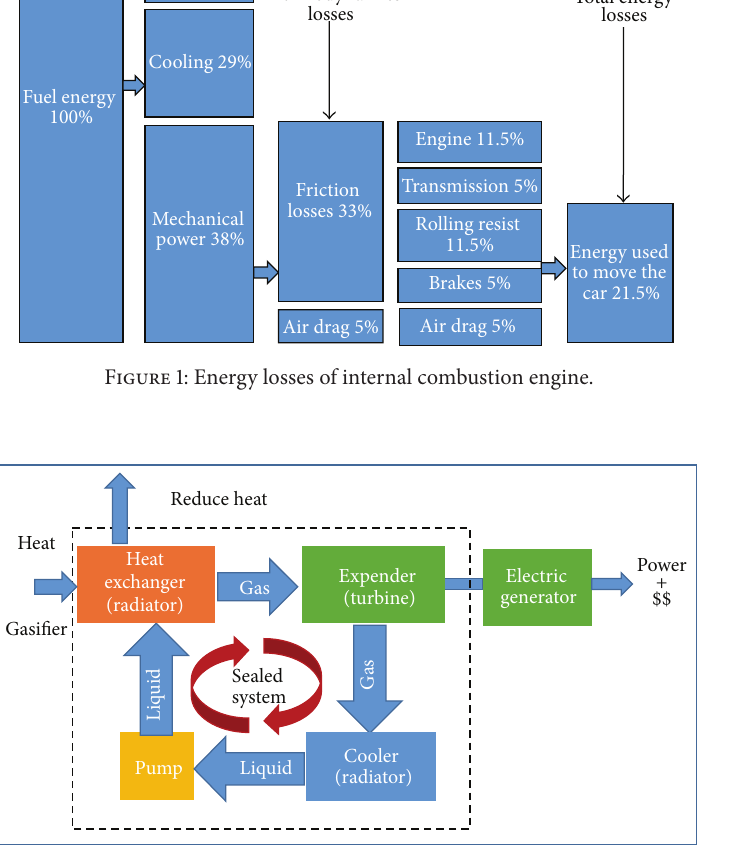
Figure 2: Organic Rankin cycle